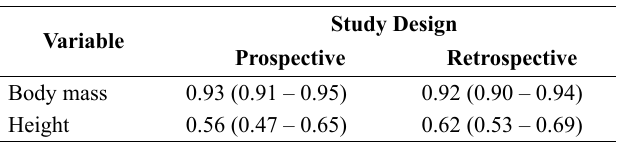
Table 2. Correlation between reported and measured measurements for height and body mass.